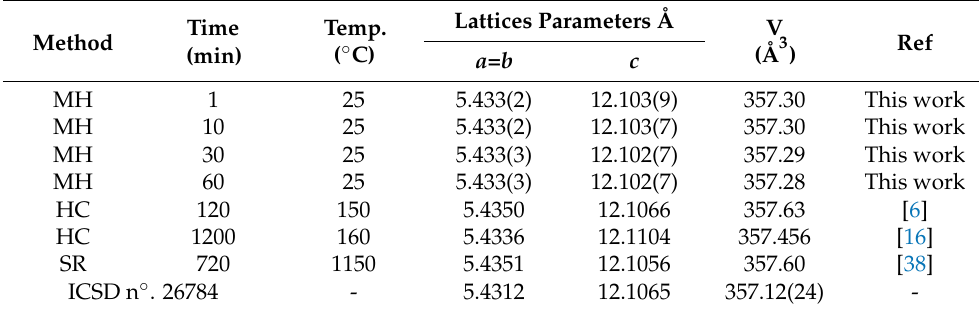
Table 1. Method, synthesis time and temperature, lattices parameters and unit cell volume (V) of the PbMoO 4 nanocrystals synthesized and reported by the references